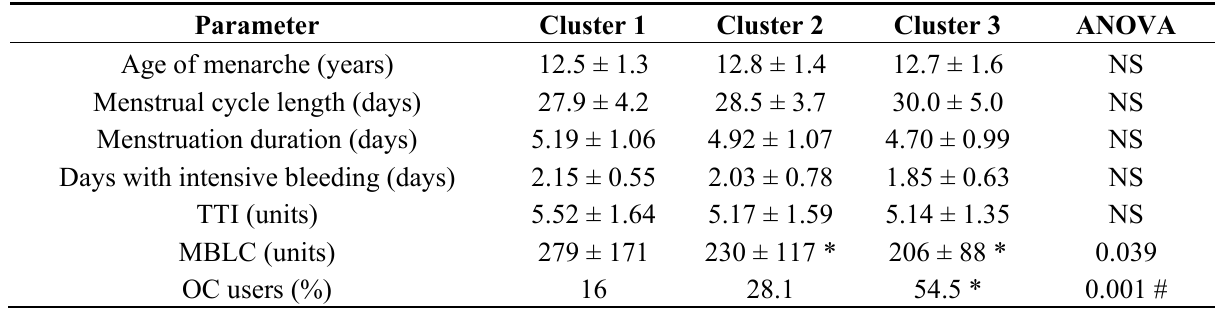
Table 3. Parameters of menstrual blood loss assessment and oral contraceptives use according to the clusters.